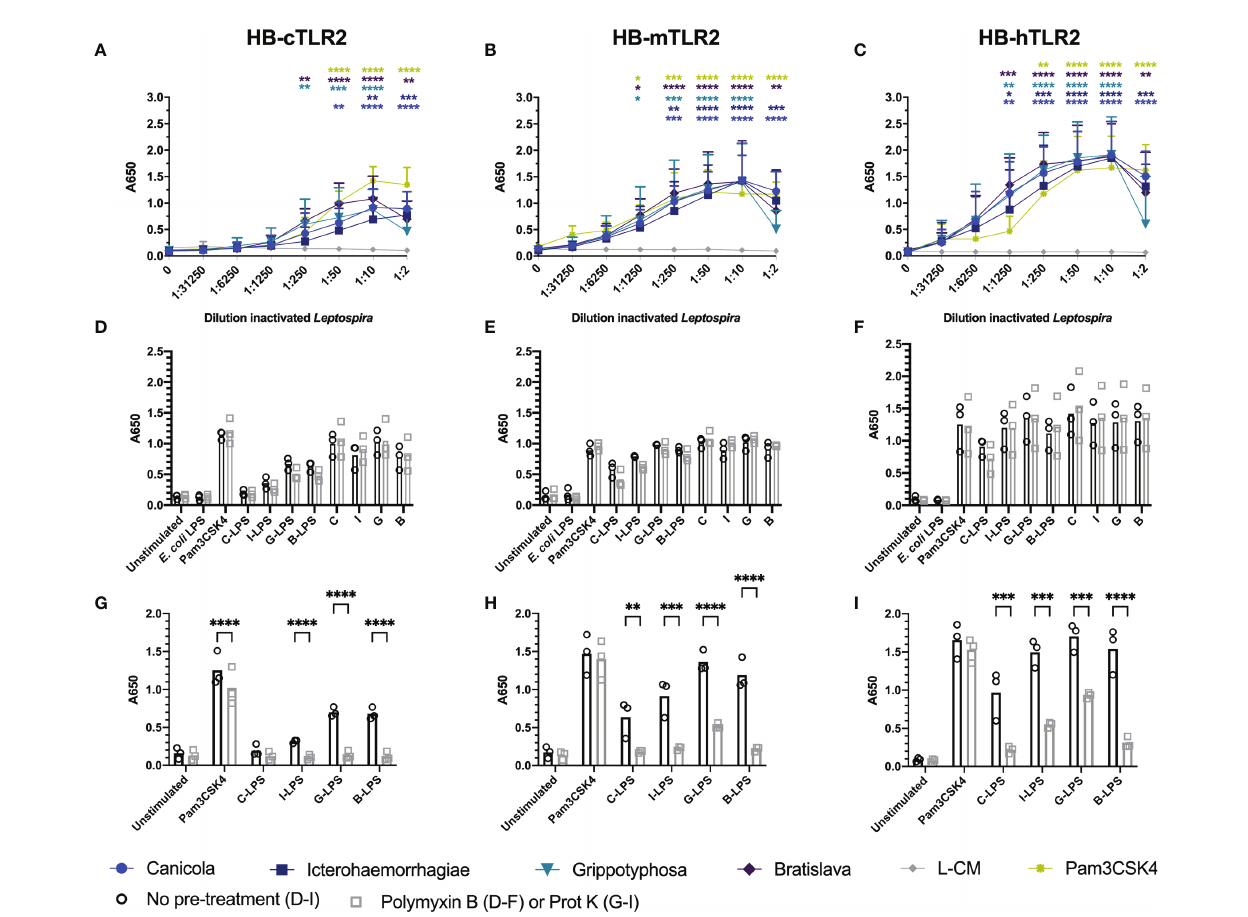
FIGURE 5 | Inactivated Leptospira activate dog, mouse and human TLR2. HEK-Blue reporter cells expressing (A) dog (HB-cTLR2), (B) mouse (HB-mTLR2) and (C) human (HB-hTLR2) TLR2 were stimulated for 24 h with serially diluted Pam3CSK4 (yellow) or leptospiral culture medium (L-CM; grey) as positive and negative control, respectively or whole-inactivated L. interrogans serogroup Canicola (circle), Icterohaemorrhagiae (square) or Bratislava (diamond) or L. kirschneri serogroup Grippotyphosa (triangle). Pam3CSK4 was diluted 10-fold starting at 10 µg/ml. Mean values from three or four independent assays per cell line are shown. Each assay was performed using two or three replicates per condition. The error bars represent the SD. A mixed-effect analysis combined with Dunnett ’ s multiple comparisons test was used to test for signi fi cance between the stimulated cells and unstimulated control (0). (D – F) Cells were stimulated with E. coli LPS, Pam3CSK4 (controls), whole-inactivated Leptospira serogroup Canicola (C) , Icterohaemorrhagiae (I) or Bratislava (B) or L. kirschneri serogroup Grippotyphosa (G) or puri fi ed leptospiral LPS (C-LPS, I-LPS, G-LPS, B-LPS) either untreated (circle) or pre-treated with polymyxin B, at a fi nal concentration of 50 µg/ml polymyxin B in cell culture (square). (G-I) Cells were stimulated with untreated (circle) or 1 mg/ml proteinase K pre-treated (square) Pam3CSK4 or puri fi ed leptospiral LPS (C-LPS, I-LPS, G-LPS, B-LPS). Mean values from three independent assays per cell line are shown (D – I) . Each assay was performed using three or four replicates per condition. A mixed-effect analysis combined with S ̌ ida ́ k ’ s multiple comparisons test was used to test for statistical signi fi cance between the untreated and polymyxin B or proteinase K treated stimulus. No signi fi cant effect of polymyxin B was found. *p < 0.05, **p < 0.01, ***p < 0.001, ****p <